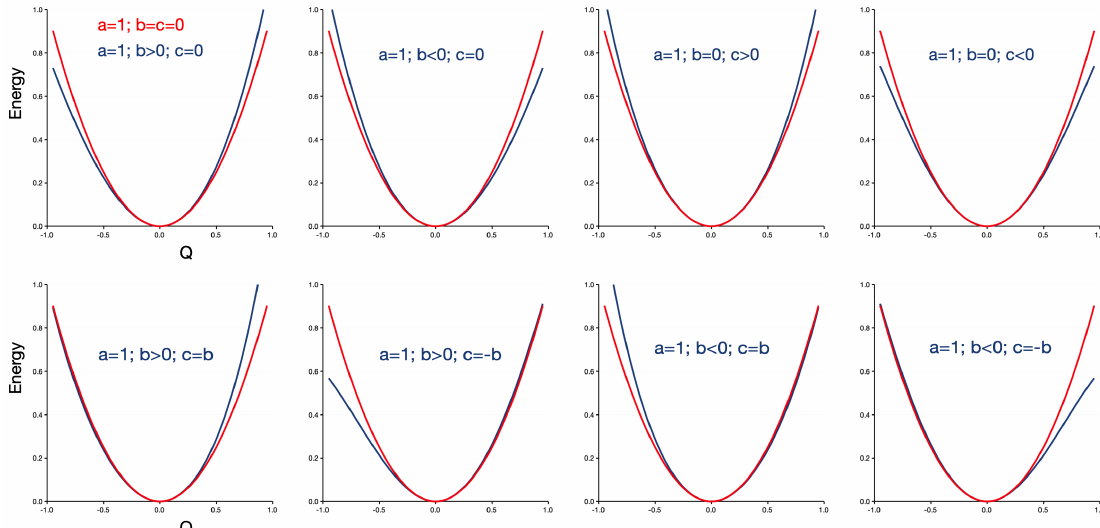
Figure 1. Influence of the cubic ( b ) and quartic ( c ) corrections (in blue) on the harmonic potential energy curve (in red). | b | and | c | are 0.2 when